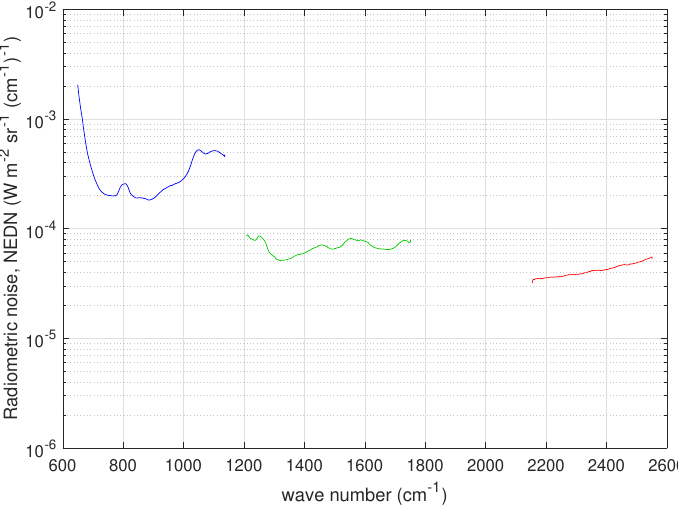
Figure 4. HIRAS radiometric noise in units of NEDN (W-m − 2 sr − 1 (cm − 1 ) − 1 ) for the three bands of the instrument. The radiometric figures have been obtained by averaging over the four HIRAS pixels and correspond to the FSR sampling of 0.625 cm − 1 of the